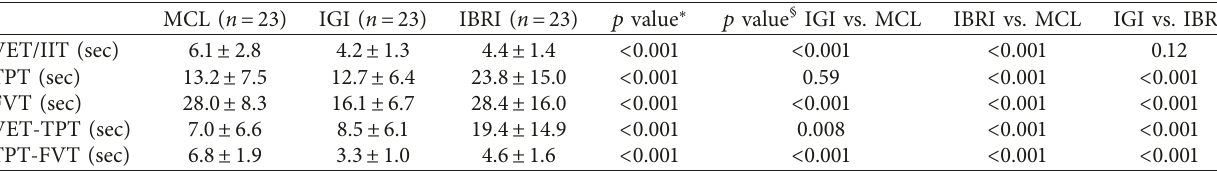
Table 2: Comparisons of intubation time among three intubation techniques regardless of kinds of endotracheal tubes.